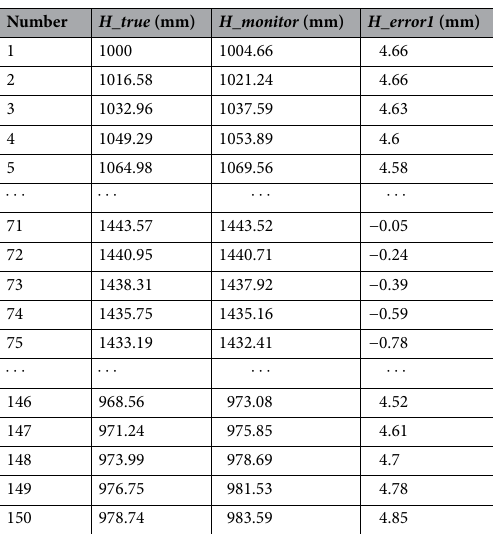
Figure 18. Advanced hydraulic support lifting process.